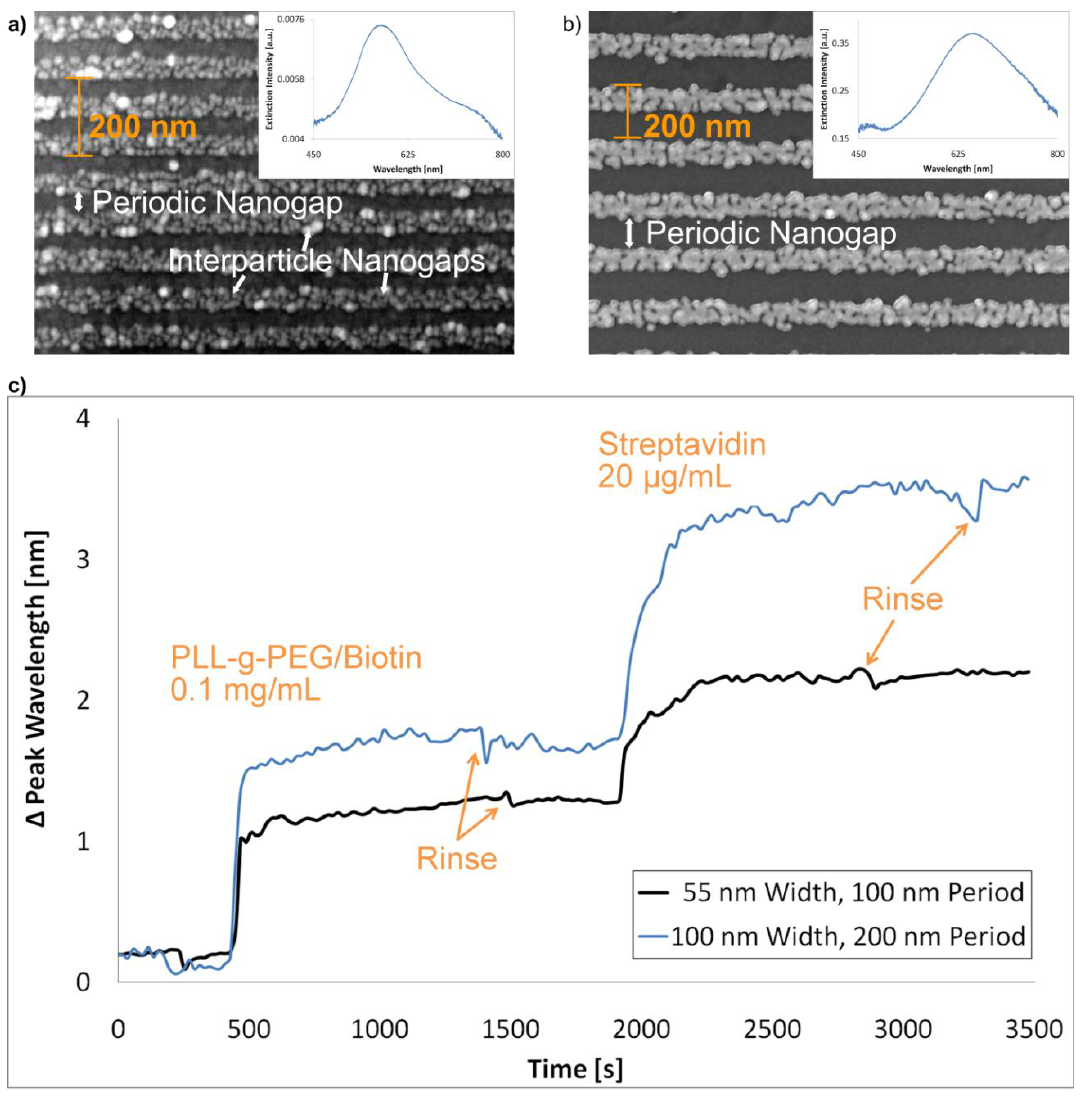
Figure 7. SEM images of a chemically enhanced particle-based nanowire arrays with a line period of (a) 100 nm or (b) 200 nm, produced with 5 nm enhanced Au particles. Inserted is the corresponding extinction spectrum of each array, but the spectrum for the 200 nm period array was obtained with perpendicularly polarized light. By tracking the LSPR response with a spectrometer in transmission mode, the peak shift of the extinction spectrum was monitored. A shift in wavelength on the order of ~1.2 nm yielded 3 σ -calculated signal-to-noise ratios near